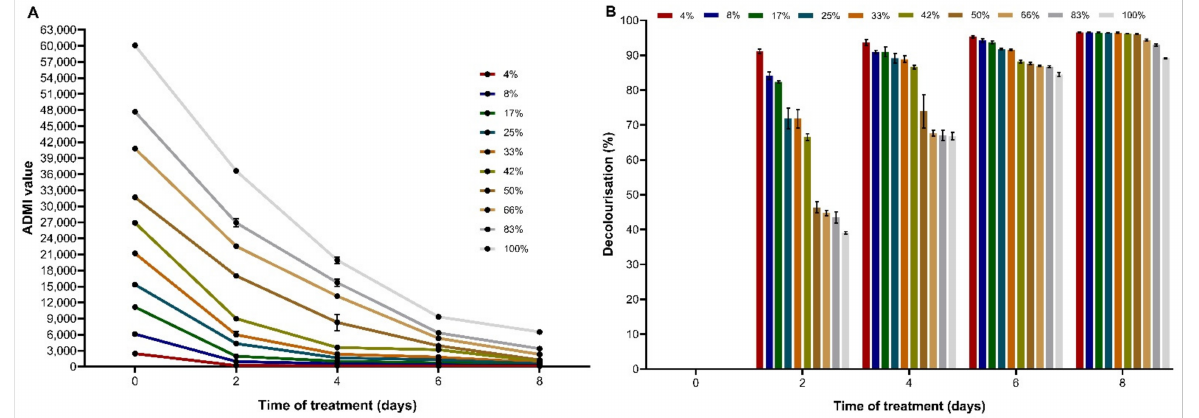
Figure 4. Effect of the initial textile dye concentration (4%, 8%, 17%, 25%, 33%, 42%, 50%, 66%, 83% and 100% ( v/v )) on decolourisation by immobilisation of T. hirsuta PW17-41 after 8 days incubation: ( A ) ADMI values of decolourisation process; ( B ) % decolourisation at different dye concentrations. Error bars indicate standard